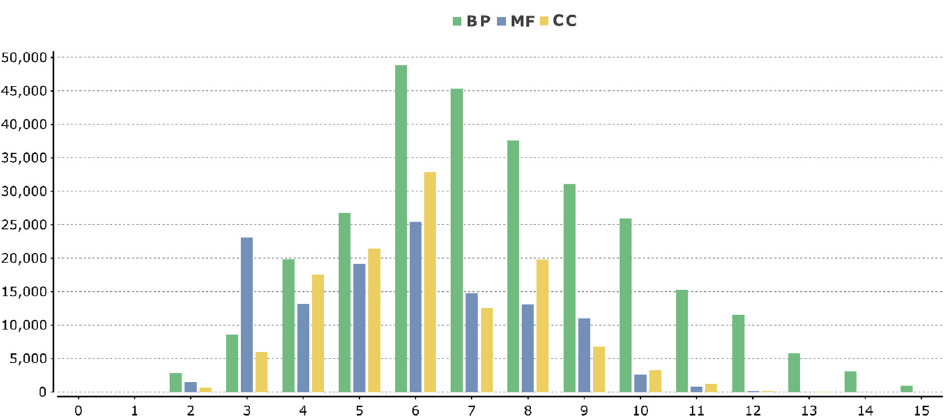
Figure 4. GO level distribution in each category for the annotated tree tomato unigenes. X axis represents the GO level and Y axis the number of annotated unigenes. BP = Biological Process, MF = Molecular Function, CC = Cellular Component.